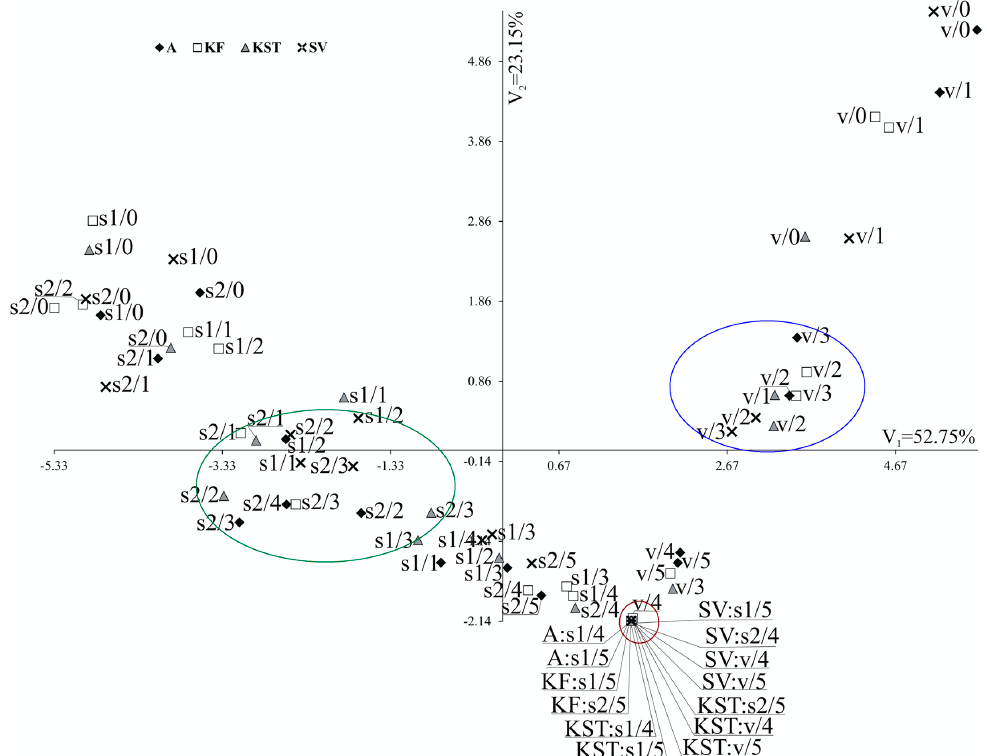
Figure 3. Distribution of 72 combinations of levels of tested factors (doses, growth substrates and cultivars) in the space of the first two canonical variables. Combination x / y denotes x—growth substrate and y—dose; v—vermiculite, s1—soil 1, s2—soil 2; doses 0, 1, 2, 3, 4 and 5 denote 0, 36, 55, 73, 108 and 145 g m − 2 of MPEO, respectively.